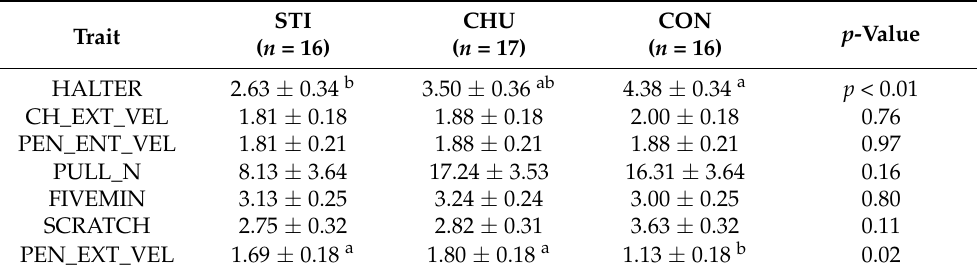
Table 5. Effect of habituation treatment on behavioral parameters during the interaction between the students and their respective heifer (Bos taurus) in the halter break practice class. STI Trait